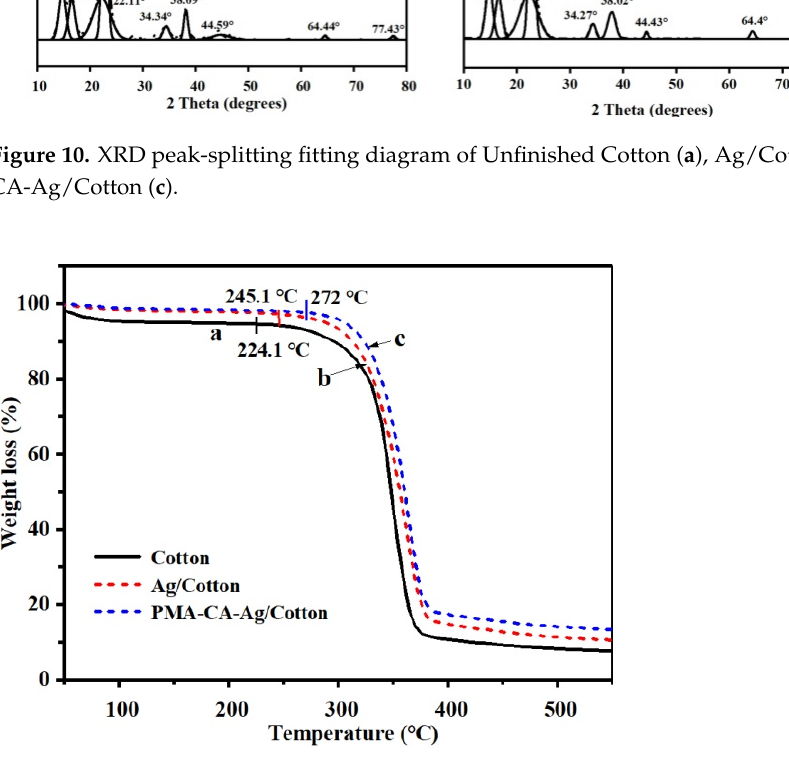
Figure 11. Thermogravimetric diagrams of Unfinished Cotton ( a ), Ag/Cotton ( b ) and PMA-CA-Ag/Cotton ( c ).